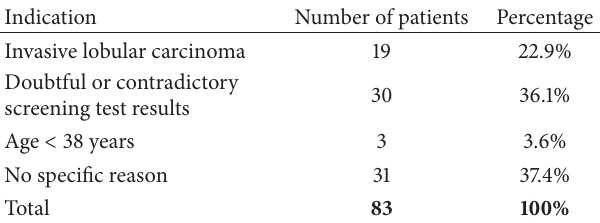
Table 2: Percentage of MRI indications in patients in subgroup II.